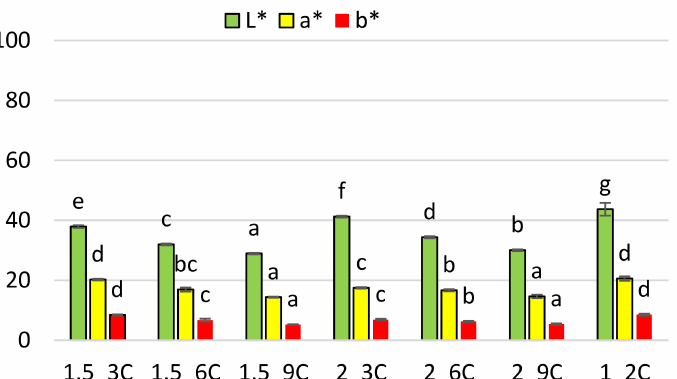
Figure 3. The effect of the amount of hydrocolloid and pomace addition on the colour in freeze-dried fruit bars with the addition of chokeberry pomace. Mean values marked with the same index letter (a–g) do not differ statistically significantly at the level of p = 0.05. Denotations in Table 1 include Index (C) next to the sample symbol—bars with the chokeberry